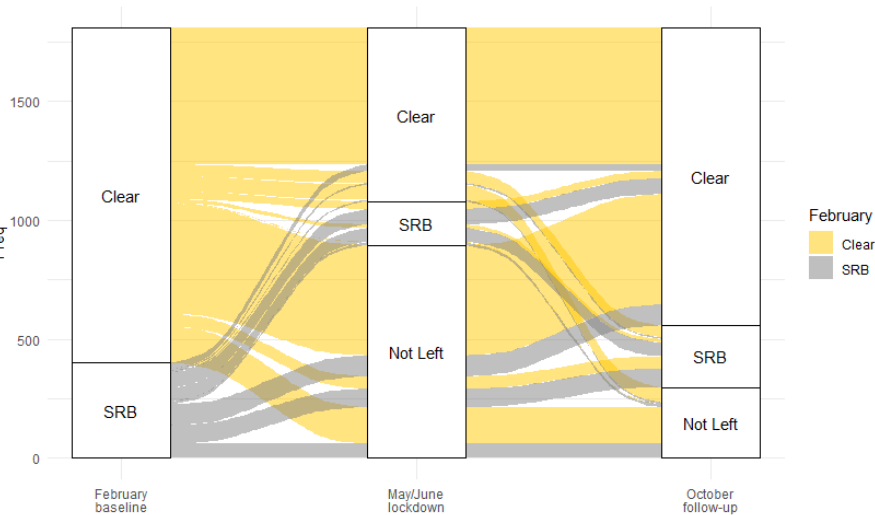
Figure 3. Alluvial (Sankey) plot showing changes in SRB status between the three study timepoints in 2020. The grey bars indicate the changing status of the dogs who were SRB+ in February 2020, and the yellow bars show the dogs were clear of SRB at baseline. The yellow and grey bars split to show movement in the status of those dogs between the other two study points, during the 1st ‘lockdown’, where almost half of dogs were not left alone, through to October 2020 in the follow-up